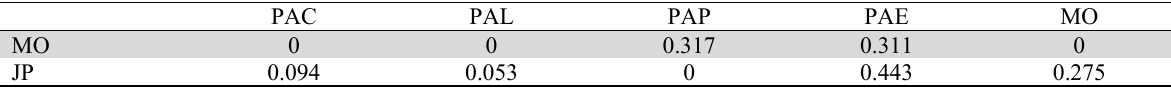
Standard Direct Effect